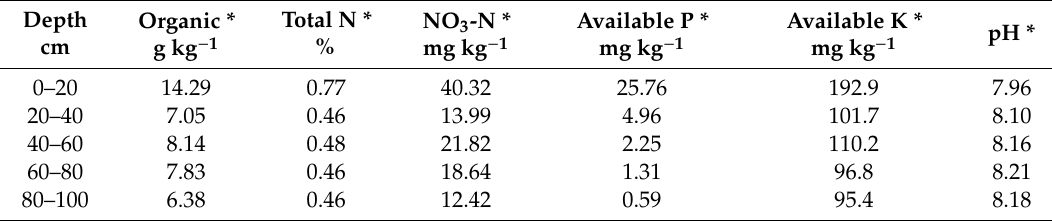
Table 2. Soil chemical characteristics in the upper 100 cm soil